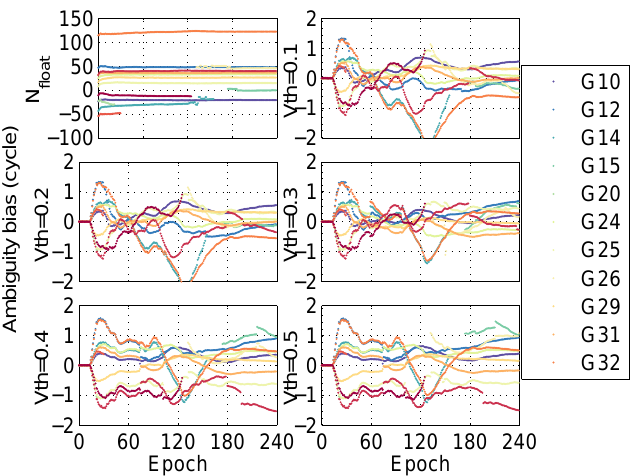
Figure 14. Ambiguity bias in different thresholds at station BSHM in the real-time PPP.